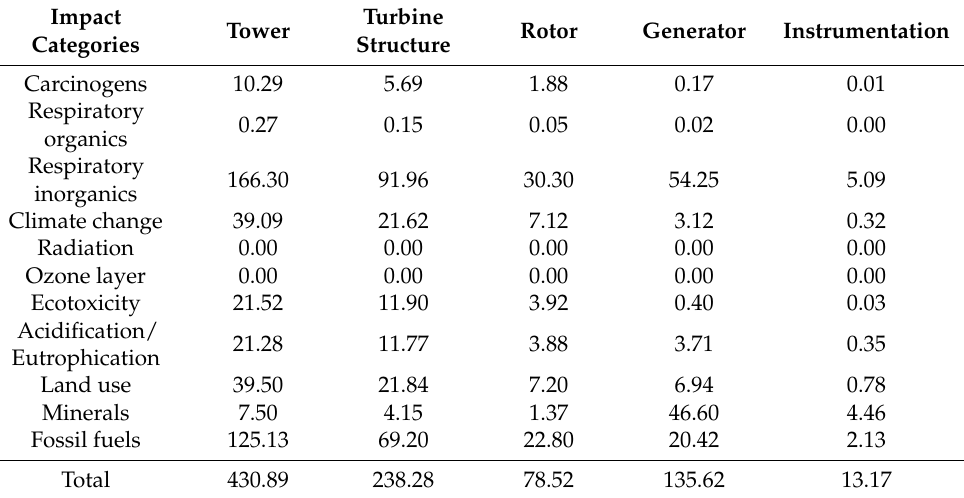
Table 2. Results of grouping and weighting of environmental impacts during the life cycle of an innovative 15 kW wind turbine -method without recycling (unit: Pt/1